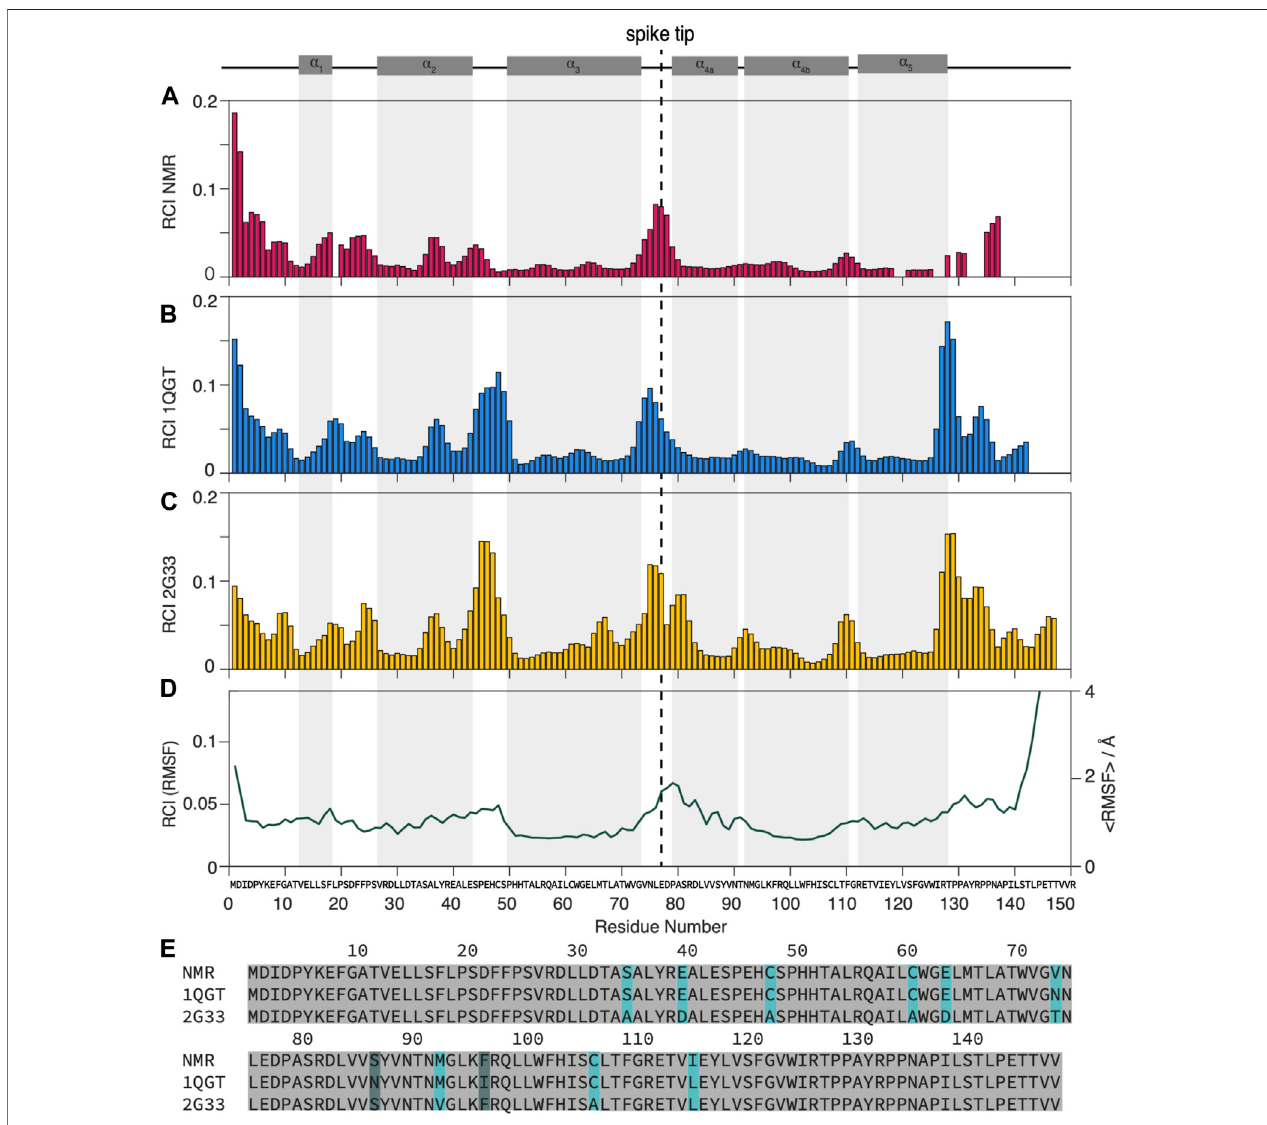
FIGURE 1 | Dynamic and static regions as distinguished by the random coil index. (A) RCI from experimental chemical-shift data (Lecoq et al., 2018, 2019), (B) from the X-ray structures used for NMR (PDB 1QGT) and (C) for MD (PDB 2G33). (D) RMSF from the MD trajectory (Hadden et al., 2018) (left scale) and RCI calculated fromtheRMSF(rightscale)bymultiplyingitbyanempiricalfactorof28.3Aaccordingto(BerjanskiiandWishart,2008). (E) Alignmentofthedifferentstrainsused:strainD for NMR, strain CW for the 1QGT crystal structure, strain ADYW for the 2G33 crystal structure and the MD calculations. The mutations between strains D and ADYW (NMR and MD) are highlighted in